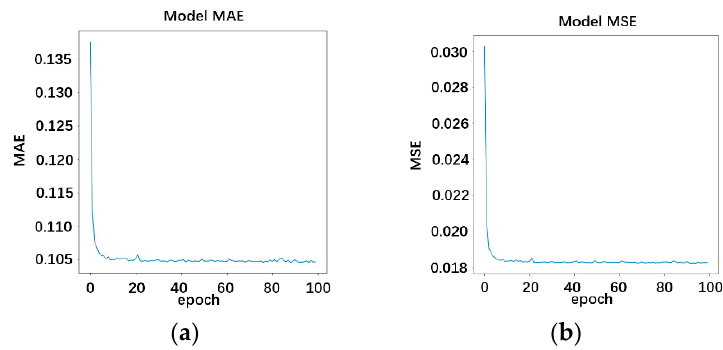
Figure 8. Model training error of 100% road quantity: ( a ) model MAE; ( b ) model MSE. Table 7. The influence of different simulation durations in the model input data on the prediction results.